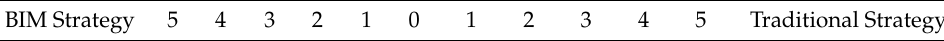
Table 1. Questionnaire scaling.